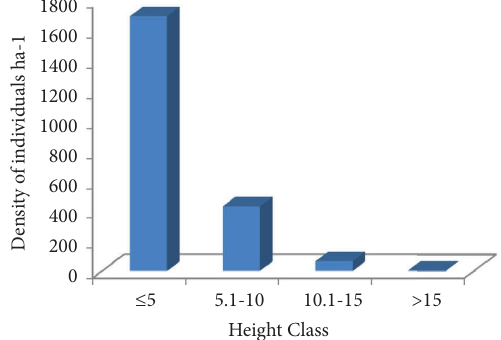
Figure 4: Distributions of woody plant individuals in the diferent height